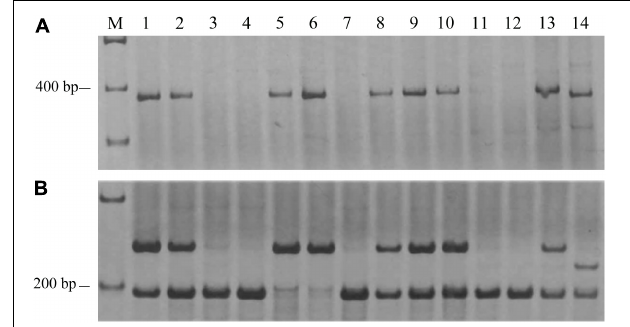
FIGURE 4 | The banding patterns of PmH962 -linked markers NL2 (A) and XTC17 (B) in the Chinese Spring (CS) homoeologous group 7 nulli-tetrasomics, ditelosomics, and deletion lines. 1, CS; 2, CSN7A-T7D; 3, CSN7B-T7A; 4, CSN7B-T7D; 5, CSN7D-T7A; 6, CSN7D-T7B; 7, CSDt7BS;